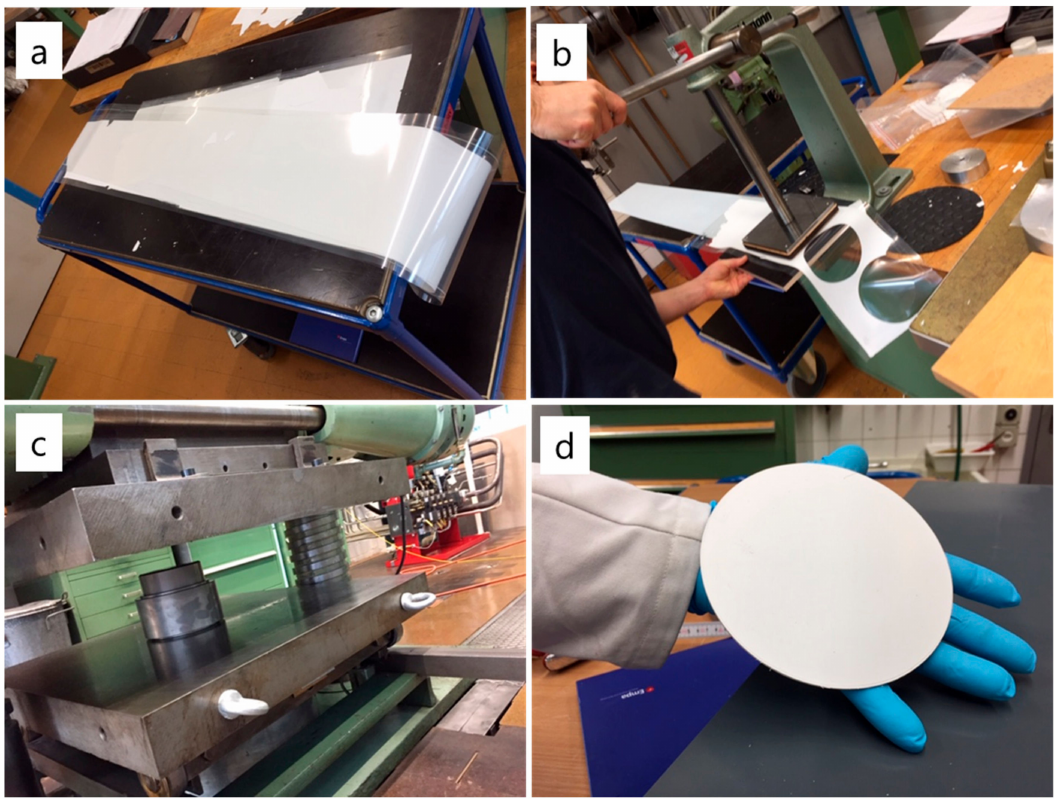
Figure 1. Production of large diameter Na- β ”-Al 2 O 3 discs. ( a ) Several meters of tape collected; ( b ) punching 140 mm discs; ( c ) warm pressing with 1.2 MN; ( d ) 1.9 mm thick green disc ready to be